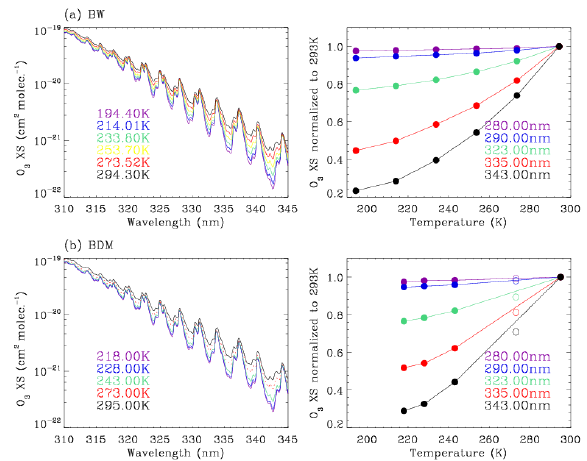
Figure 1. Left: measurements of ozone absorption cross-sections at all selected temperatures in the Huggins bands taken from (a) BW 2018 and (b) BDM 1995, respectively. Right: for BW, the experi- mental data are plotted without the quadratic parameterization for a fair comparison with BDM. BDM measurements at 273K are plot- ted with a dotted line on the left and with open circles on the right, because the data at this temperature are not recommended for use, by Liu et al.